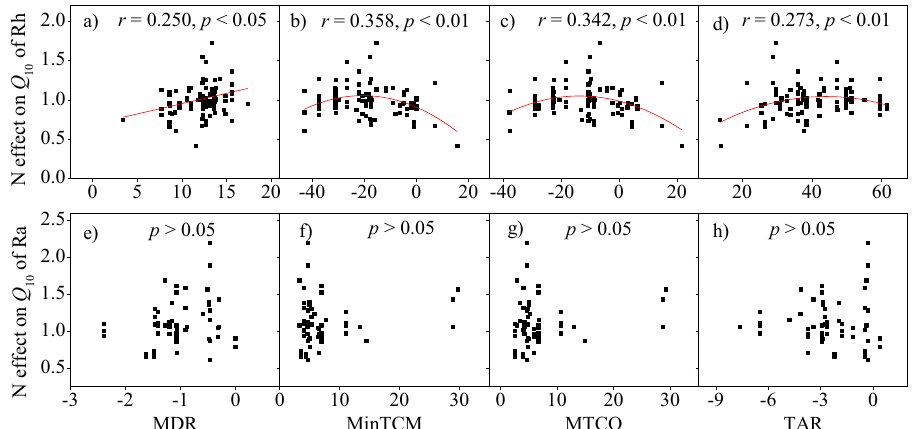
Fig. 4 Dependence of the in fl uence of nitrogen enrichment on the temperature sensitivity of soil respiration on past thermal conditions. The relationships between indices of temperature from paleoclimate and the nitrogen effects on the temperature sensitivity of soil heterotrophic ( a – d ) and autotrophic respiration ( e – h ) across all ecosystems. MDR, MinTCM, MTCQ, and TAR denote mean diurnal range, minimum temperature of coldest month, mean temperature of coldest quarter and temperature annual range, respectively. Results of linear mixed effect model are seen in Supp. Table